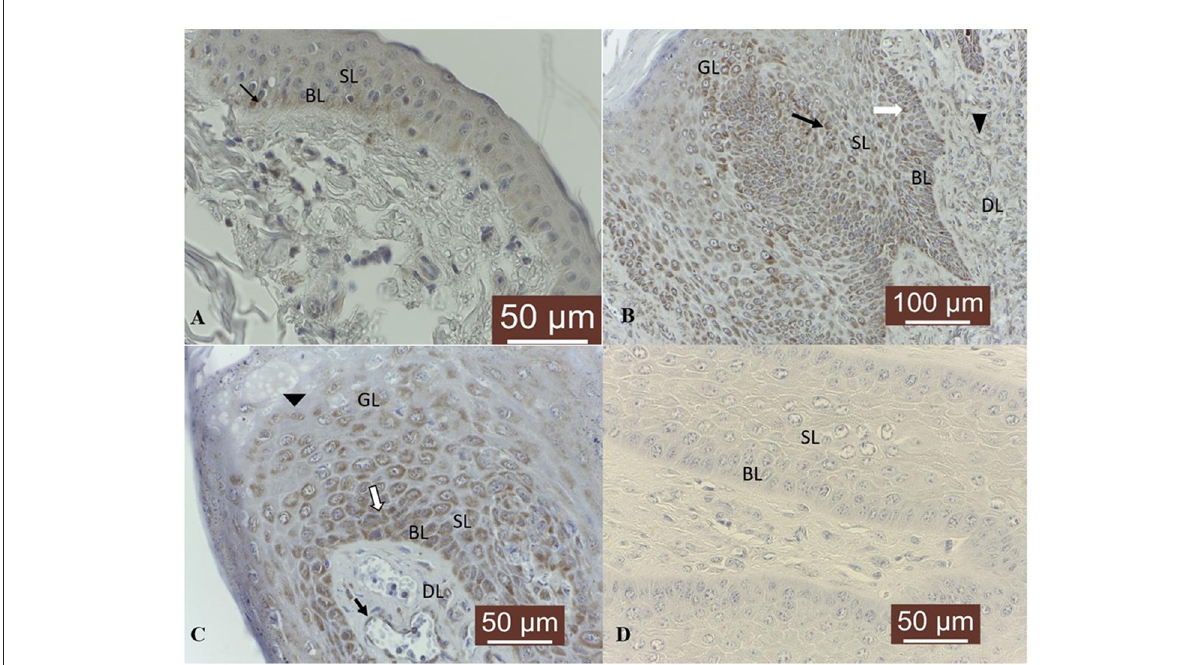
FIGURE4 MMP-9 immunostaining in bovine normal skin and fibropapillomas: (A) In bovine normal skin, a weak specific immunoreactivity for MMP-9 is noted in the cytoplasm of cells from basal cell layer (BL) (black arrow); 40 X. (B) In bovine fibropapillomas, MMP-9 is expressed by keratinocytes from basal (BL) (white arrow), spinosum (SL) (black arrow) and granular (GL) epithelial layers and fibroblast cells (black arrowhead) from dermal layer (DL); 20 X. (C) Strong cytoplasmic and perinuclear (white arrow) immunoreactivity of MMP-9 in keratinocytes from BL, SL, and GL (black arrowhead) of fibropapilloma; note the positivity of blood vessels (black arrow); 40 X. (D) Negative control: fibropapilloma with the first antibody anti-MMP-9 omitted and incubated with secondary antibody did not stain; 40 X.